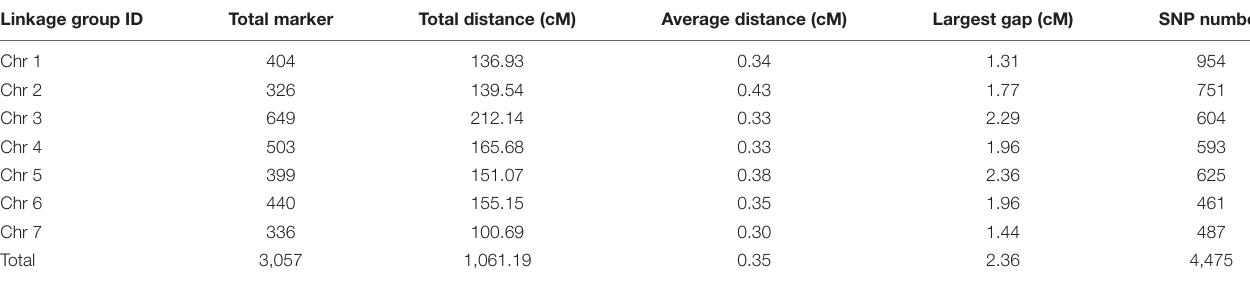
TABLE 3 | Description on basic characteristics of seven linkage